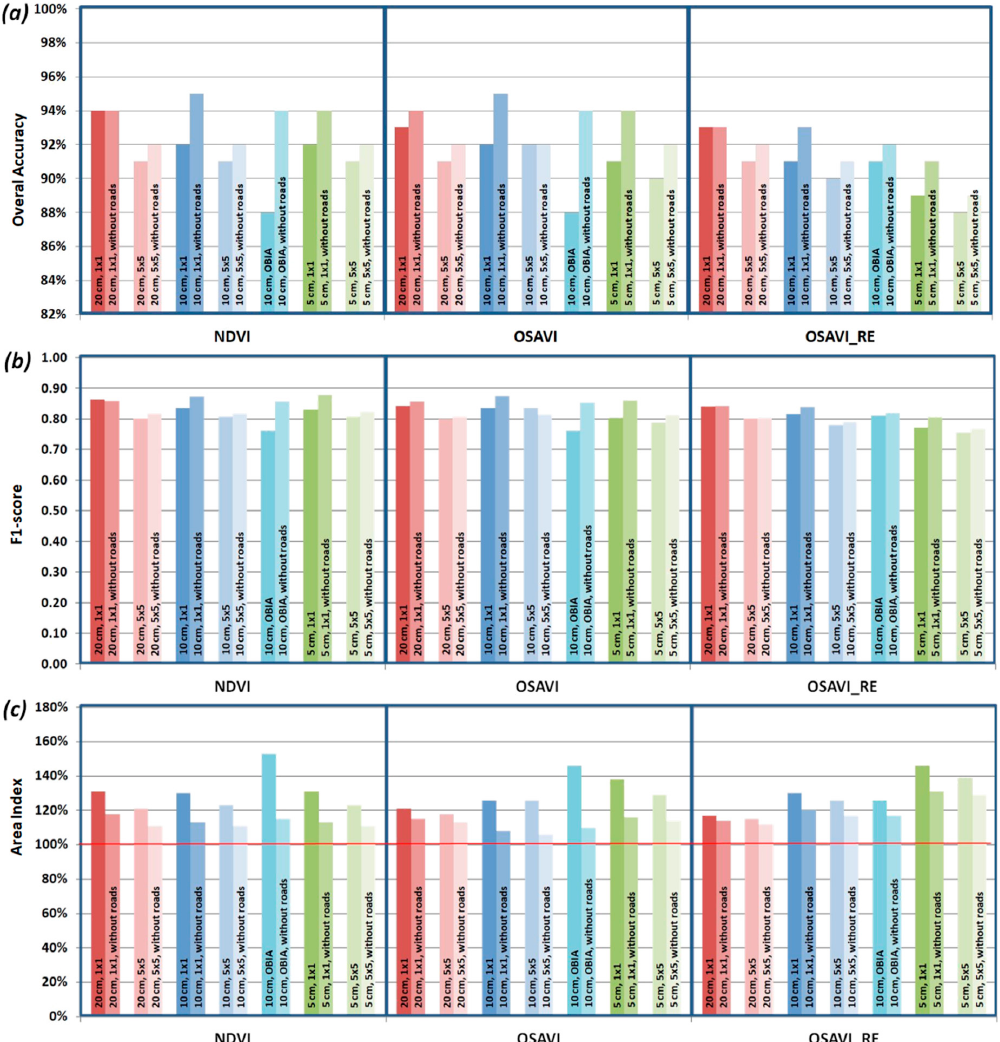
Figure 9. The comparison of the overall accuracy (OA) ( a ), the F1-score ( b ), and area index (AI) ( c ) of all variants of classifications.